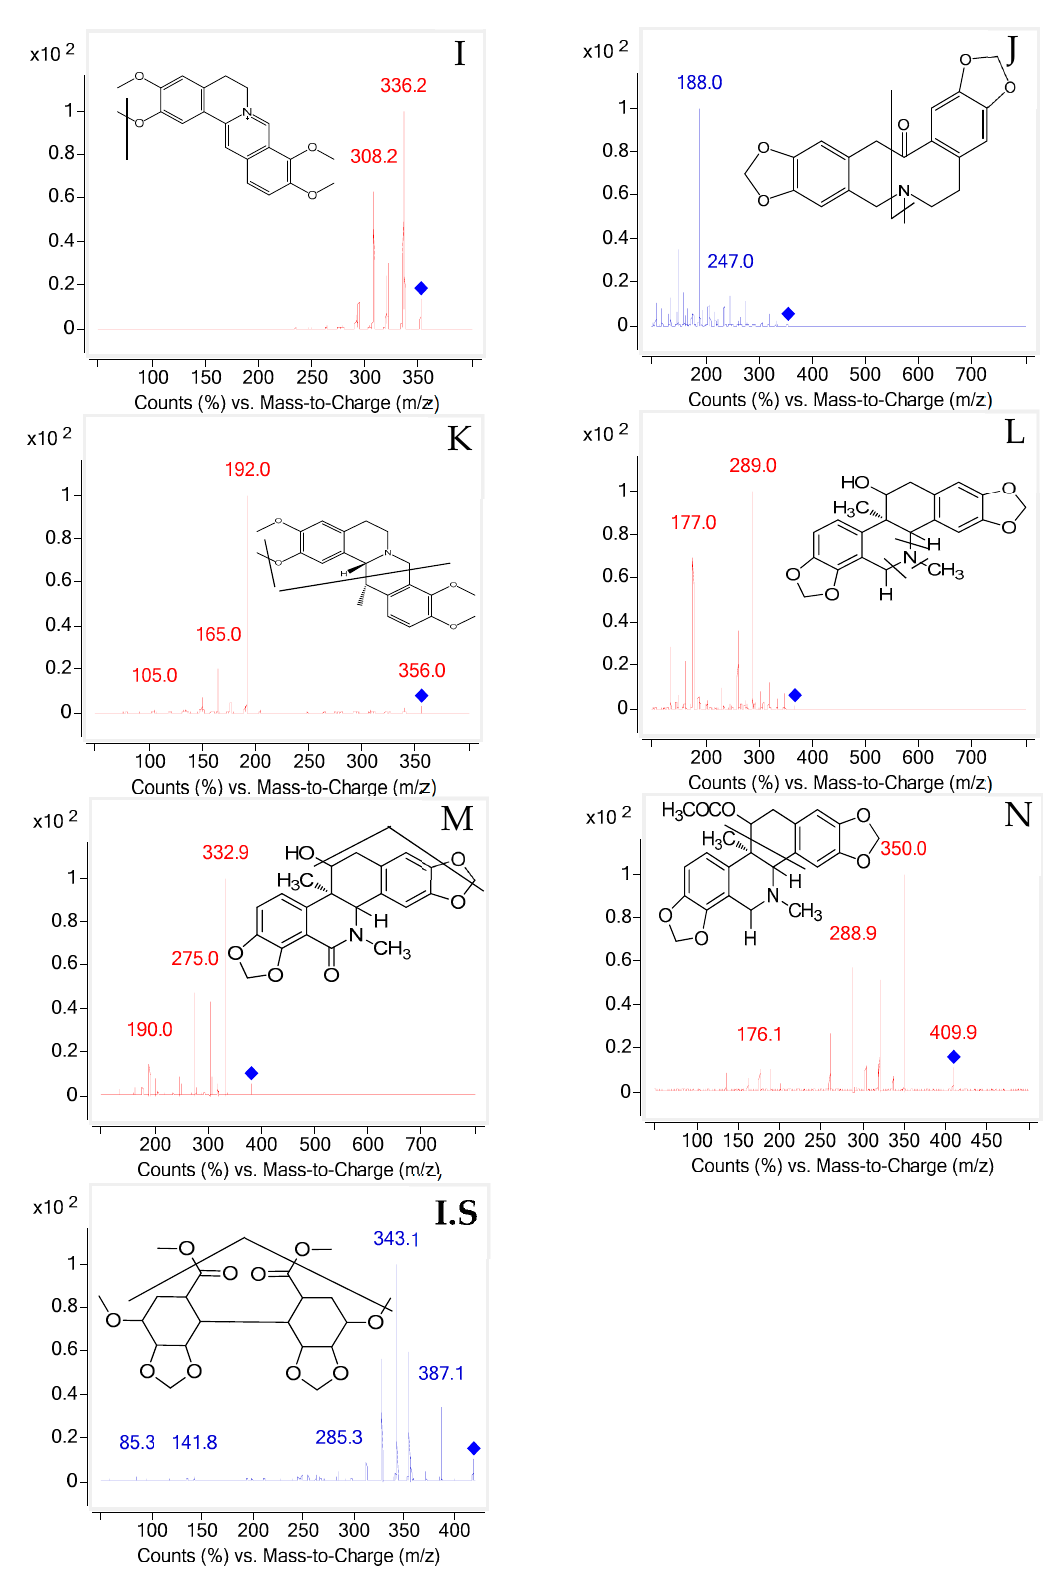
Figure 3. MS/MS fragmentation patterns of ( A ) 7 ′ -(3 ′ ,4 ′ -dihydroxyphenyl)- N -[(4-me thoxyphenyl)- ethyl]propena-mide/Z23, ( B ) coptisine, ( C ) berberrubine, ( D ) berberrubine, ( E ) worenine, ( F ) berberine, ( G ) jateorhizine, ( H ) columbamine, ( I ) palmatine, ( J ) protopine, ( K ) tetrahydropalmatine , ( L ) corynoline, ( M ) 8-oxocorynoline, ( N ) acetylcorynoline and ( I.S ).